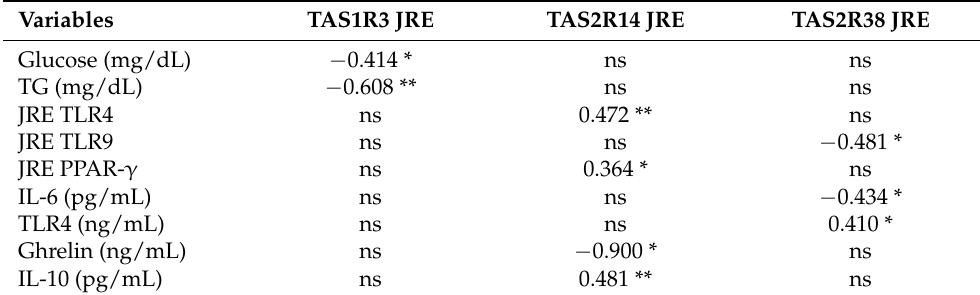
Table 3. Significant correlations between different parameters and TAS1R3, TAS2R14 or TAS2R38 jejunal relative expression in the whole cohort of studied